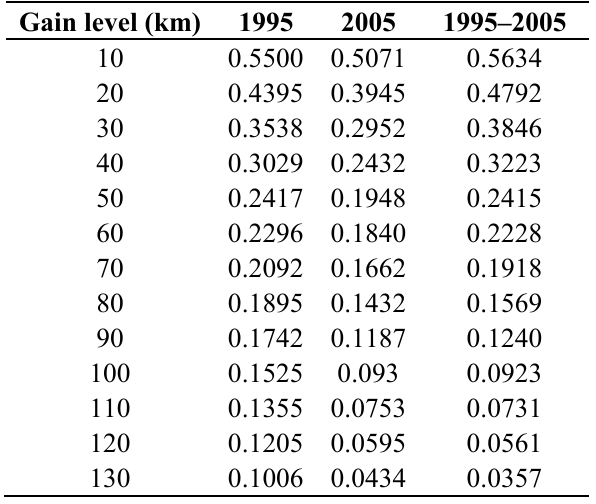
Table 3. Moran’s I of land use eco-risk index at different grain levels in the Poyang Lake Eco-economic Zone.